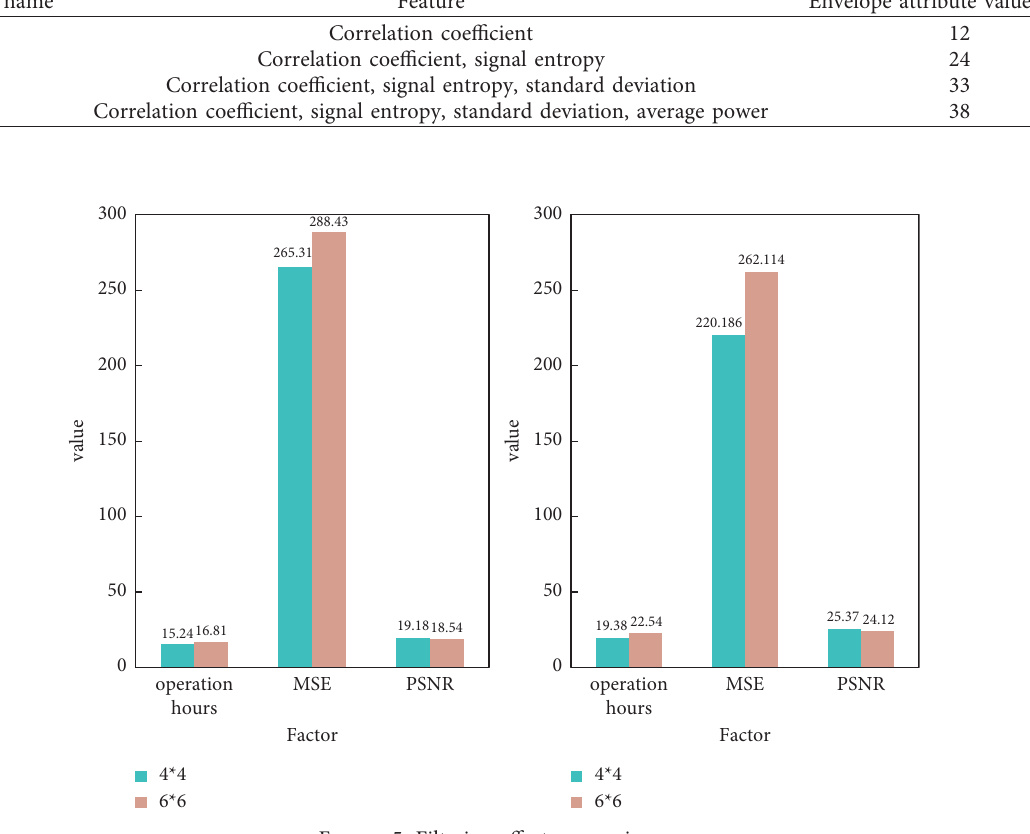
Figure 5: Filtering effect